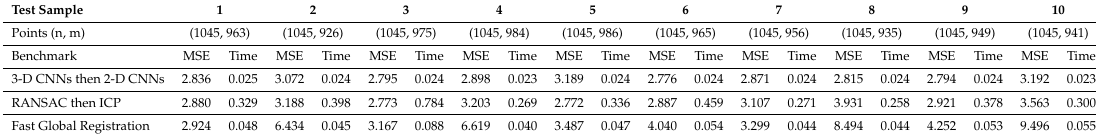
Table 7. The comparisons about MSE and computation time of “Buddha” data for test samples from 1 to 10. TestSample